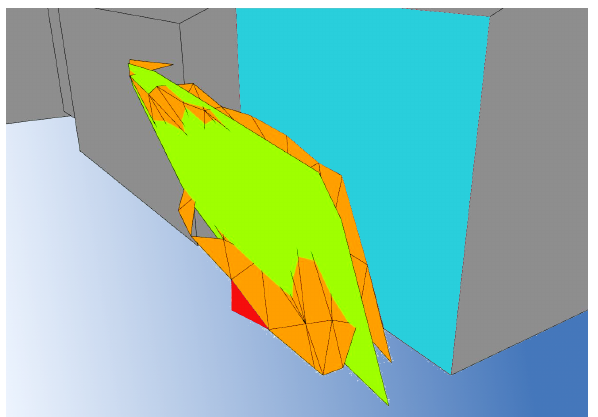
Figure 7. Plane (green) fitted through vertices of the triangle seed (orange) with the corresponding semantic surface (blue) in the back. The current candidate triangle is highlighted red.